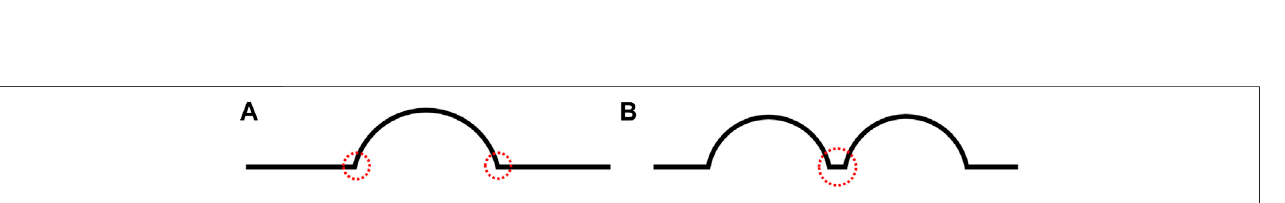
FIGURE 13 | Model of skin deformation. In (A) , there is only one hole and the deformation at the edge of the suction hole is small. In (B) , two suction holes are adjacent to each other, and the skin deformation is greater.